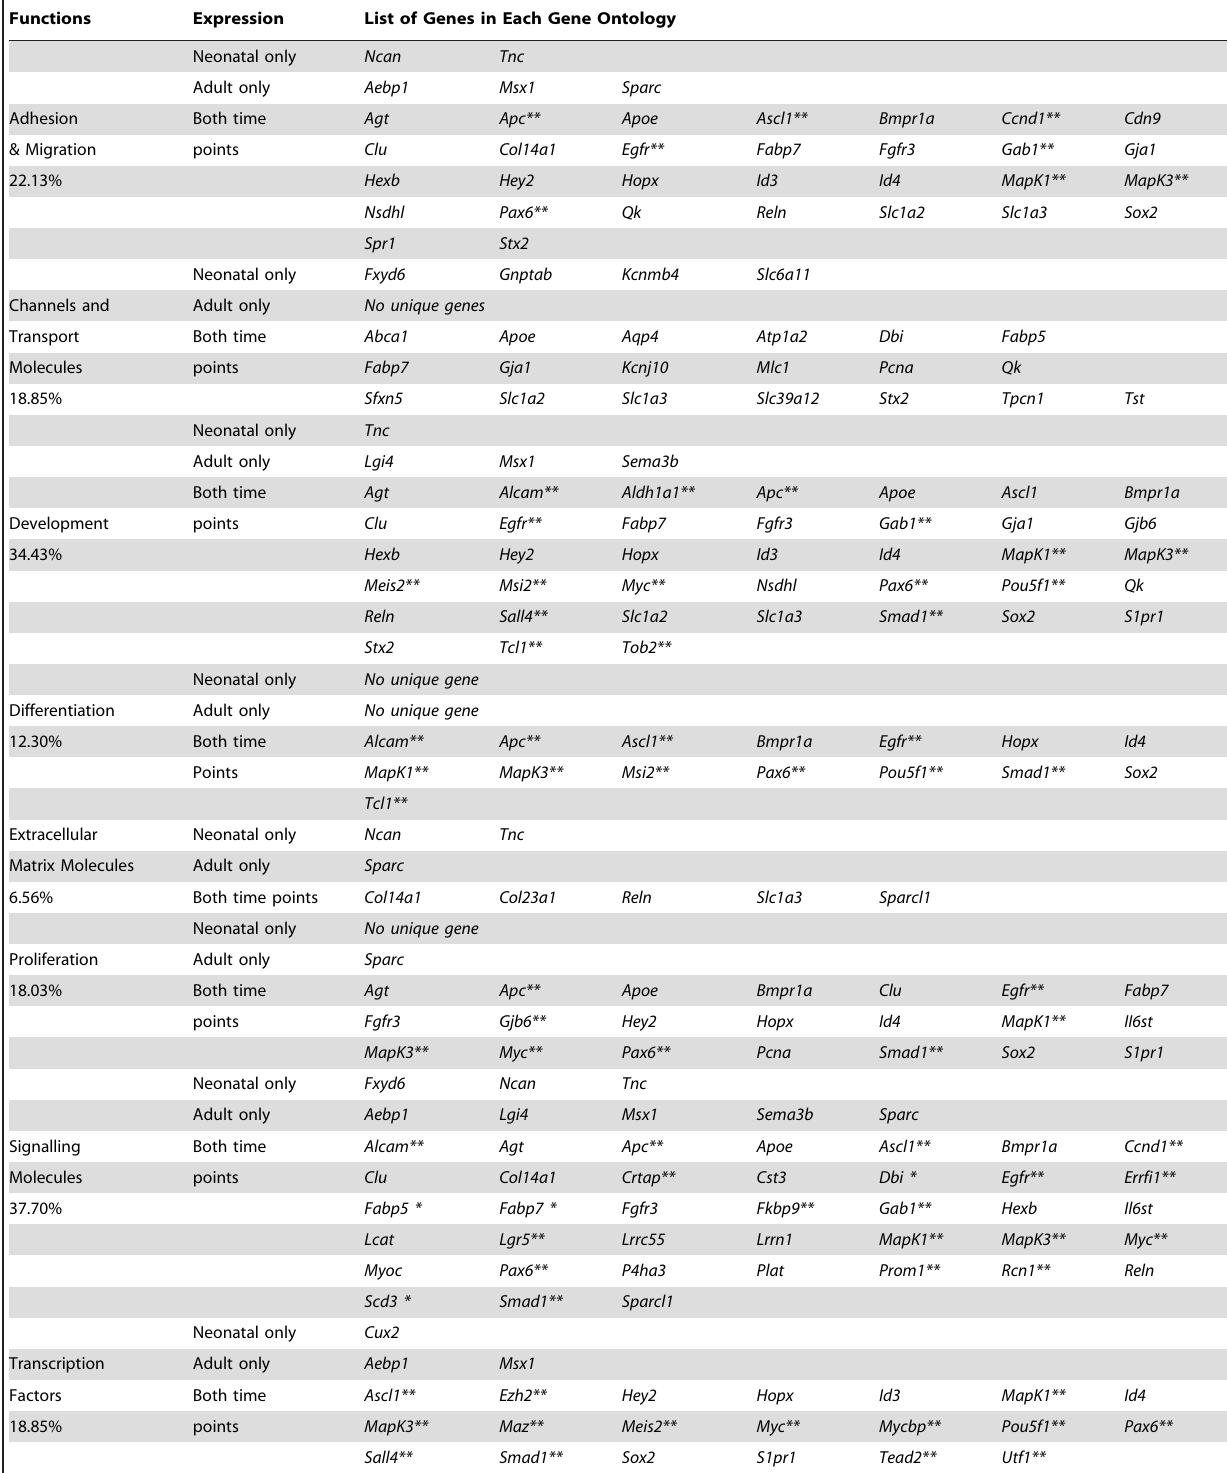
Table 1. Transcriptional Profile of SCRG Highlights a Progenitor Cell